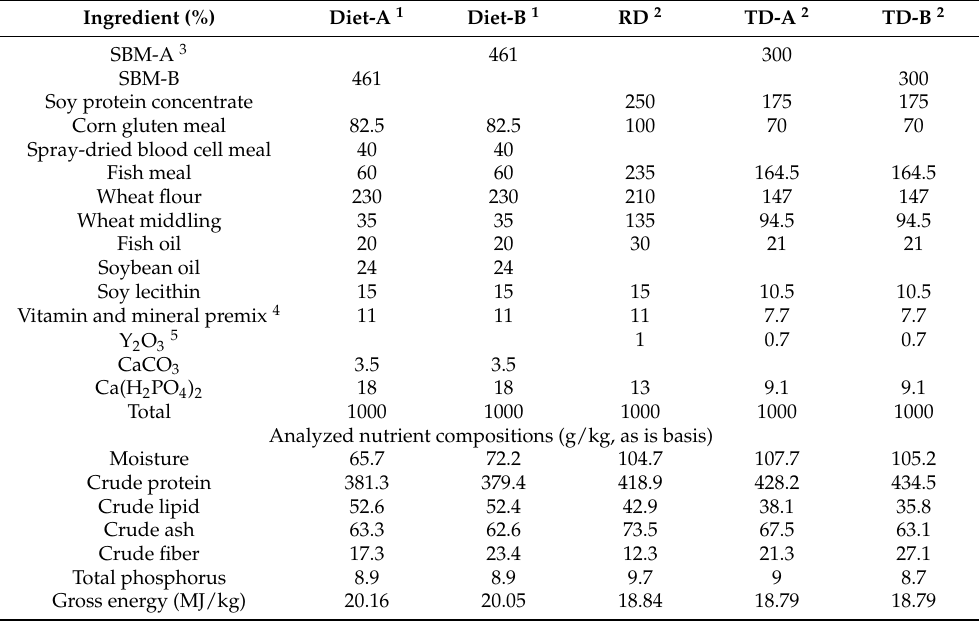
Table 1. Dietary formulation and nutrient compositions of experiment 1 and experiment 2 (g/kg, as is